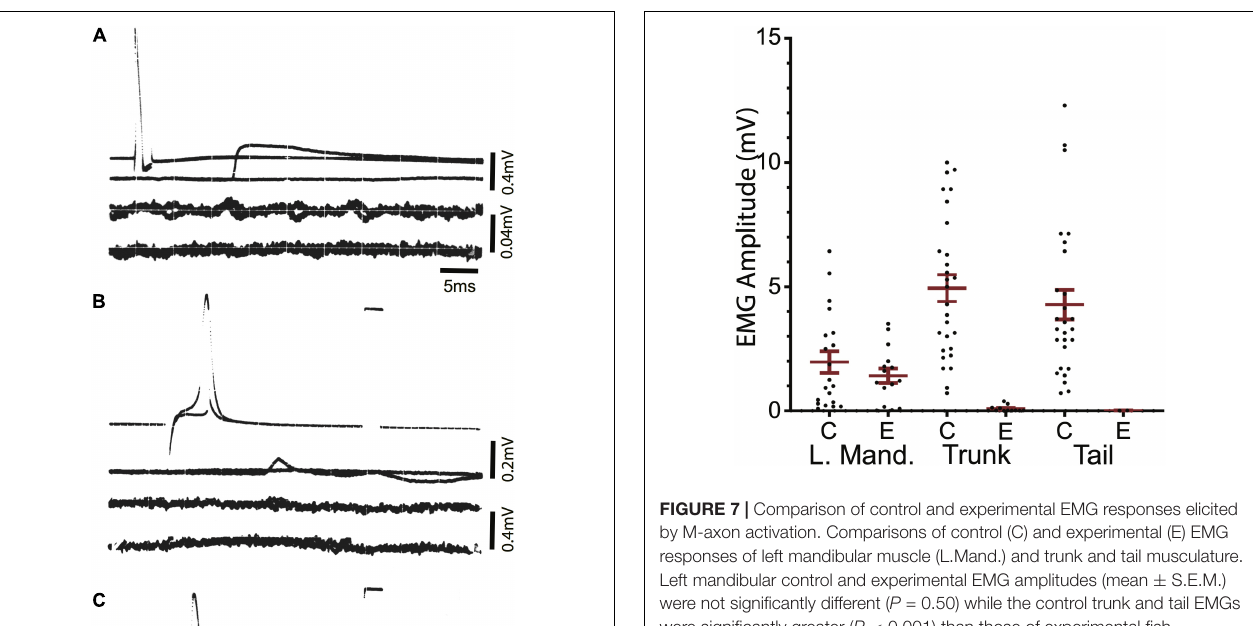
recorded in the tail musculature (0.014 and 0.011 mV). Examples were recorded are presented in Figures 6B,C . Activation of the